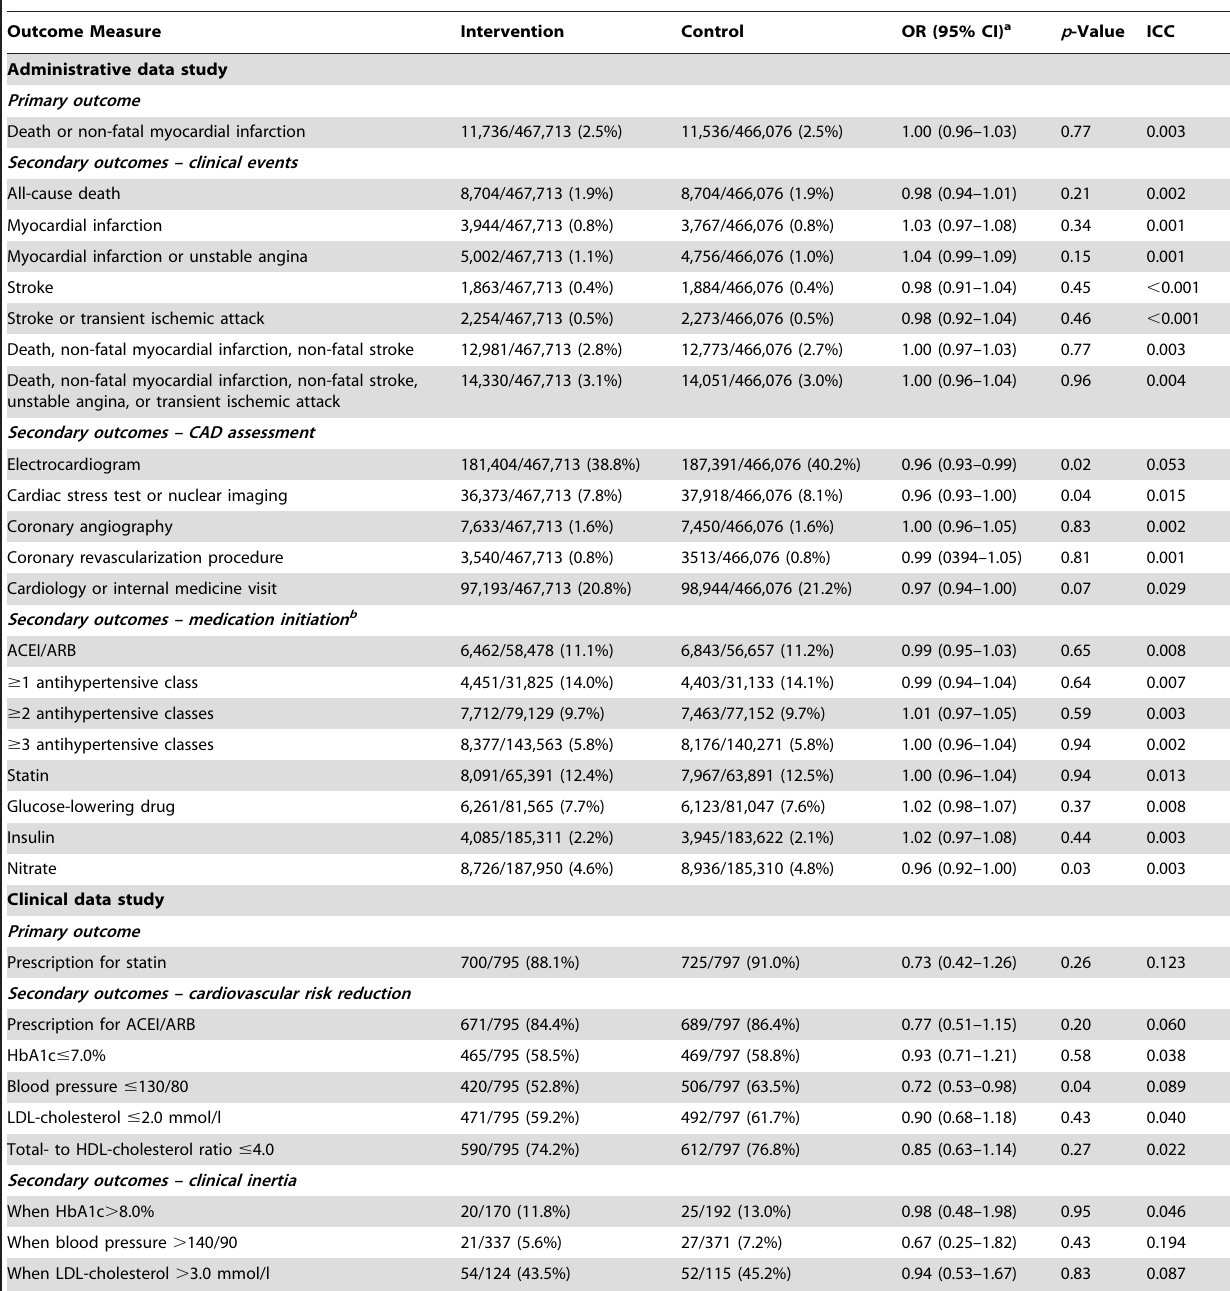
Table 2. Primary and secondary outcomes of the toolkit